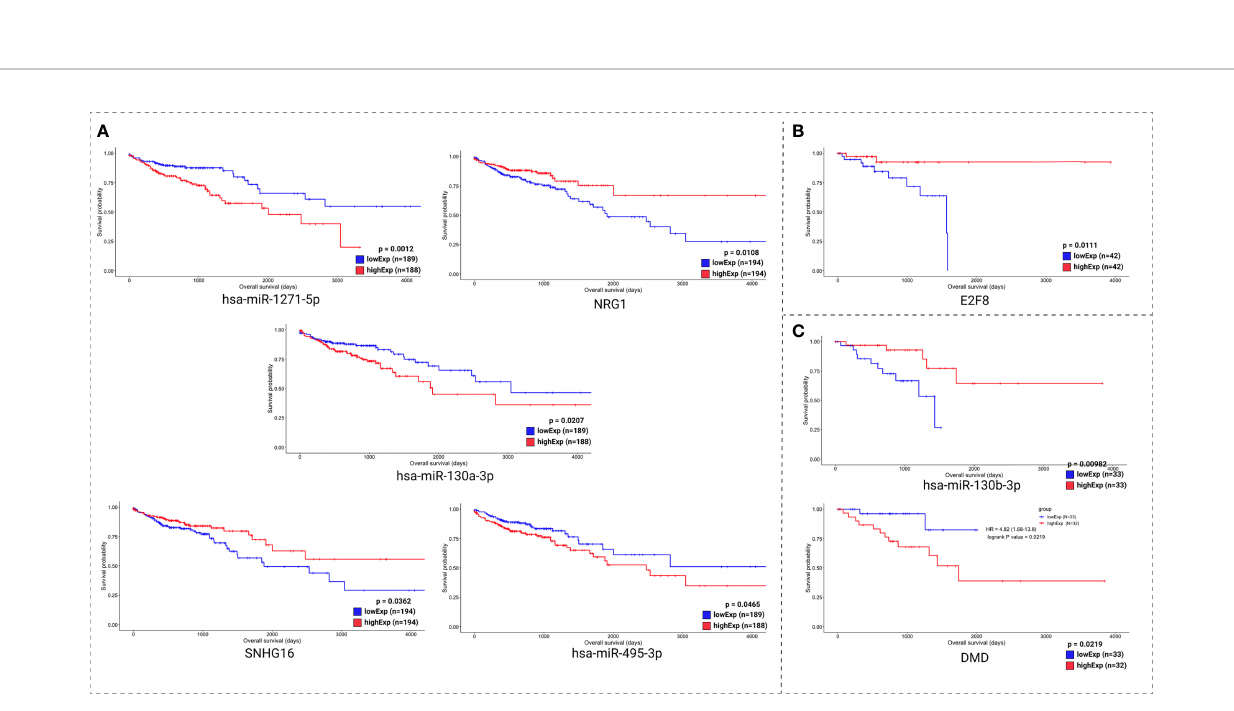
FIGURE 8 | Kaplan-Meier survival curves for the best scored molecules with top HR from CoxPH for colon (A) , rectum (B) , and rectosigmoid junction (C)